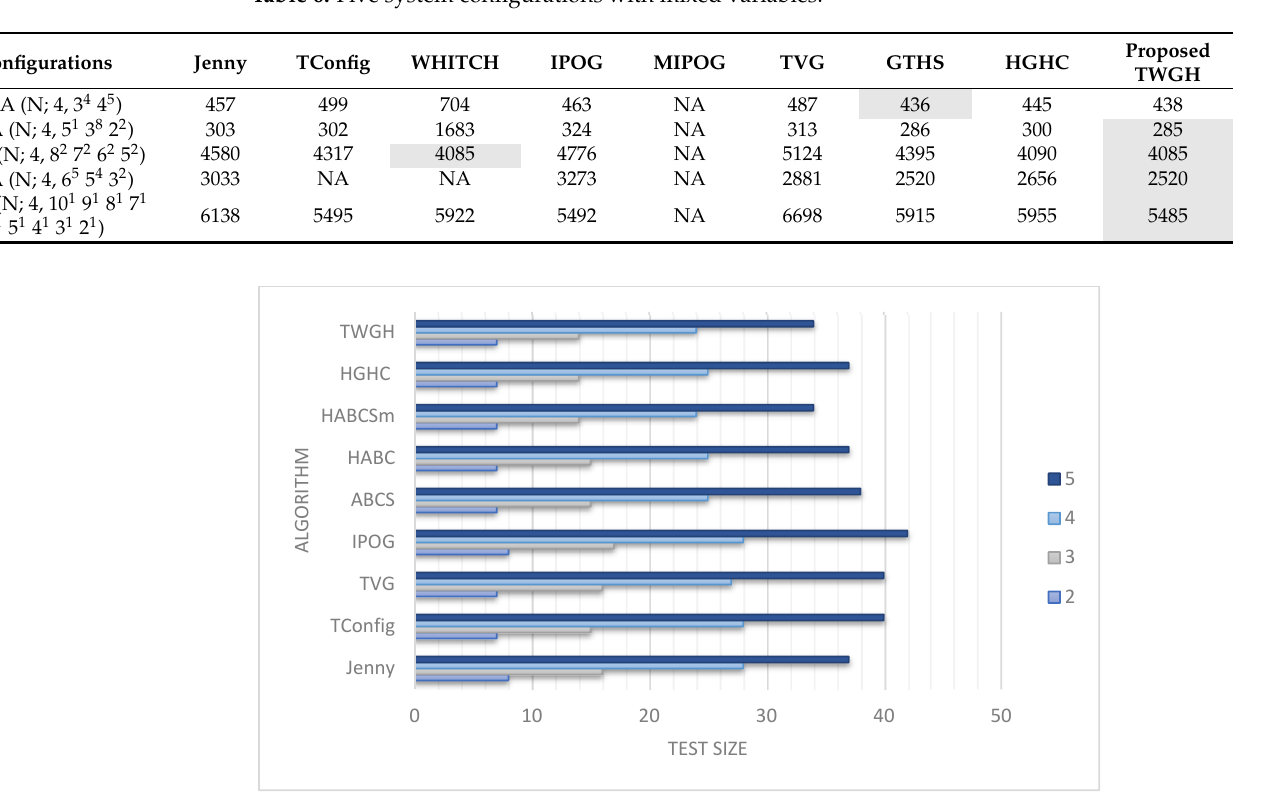
Figure 2. Test set size for CA (N; t, v 7 ) with t=2 and 2 ≤ v ≤ 5.